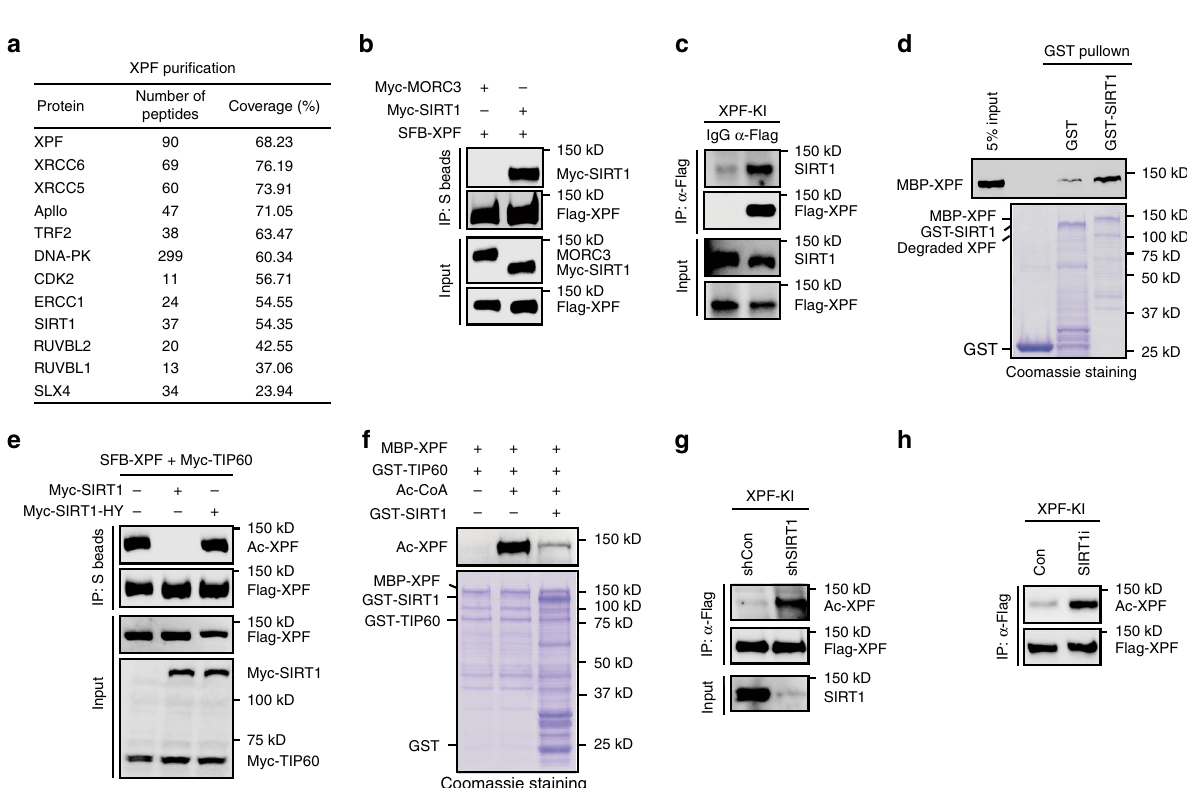
Fig. 4 SIRT1 interacts with and deacetylates XPF. a Tandem af fi nity puri fi cation of XPF protein complexes from HEK293T cells stably expressing SFB- tagged XPF. Proteins identi fi ed by Mass spectrometry analysis are listed. Bait protein is indicated in bold letters. b SIRT1 interacts with XPF. HEK293T cells were transiently transfected with the indicated plasmids for 24h. Whole-cell lysates were then prepared and subjected to immunoprecipitation with S beads and western blot analysis was carried out as indicated. c Association of endogenous SIRT1 with XPF. Whole-cell lysates prepared from XPF-SFB knock-in HeLa cells were incubated with protein A agarose beads conjugated with anti-Flag antibody and western blot analysis was carried out as indicated. d SIRT1 directly interacts with XPF in vitro. Upper panel: XPF was detected by immunoblotting. Lower panel: Puri fi ed proteins were resolved by SDS-PAGE and visualized by Coomassie blue staining. e SIRT1 mediates XPF deacetylation. HEK293T cells were transfected with the indicated plasmids for 24 h. Whole-cell lysates were then prepared and subjected to immunoprecipitation with S beads and western blot analysis was carried out as indicated. f SIRT1 deacetylates XPF in vitro. XPF proteins puri fi ed from E. Coli were acetylated by recombinant TIP60 proteins in vitro. Subsequently, acetylated XPF, as a substrate, was incubated with recombinant SIRT1 protein at 37 °C for 30 min. The reaction mixtures were then subjected to SDS PAGE and immunoblotted with anti-acetyl lysine antibody (Upper panel). Puri fi ed proteins were resolved by SDS-PAGE and visualized by Coomassie blue staining (Lower panel). g , h SIRT1 depletion or inhibition increases XPF acetylation. XPF-SFB knock-in HeLa cells were infected with SIRT1-speci fi c lentiviral shRNAs or were treated with SIRT1 inhibitor EX527 (20 μ M) for 6 h. Whole-cell lysates were then incubated with protein A agarose beads conjugated with anti-Flag antibody and western blot analysis was carried out as indicated. Source data are provided as a Source Data fi